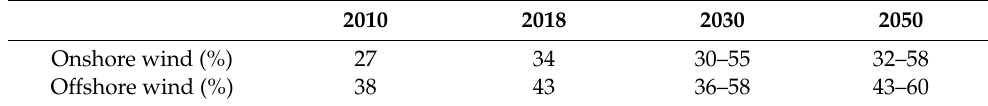
Table 3. Average capacity factor of wind turbines